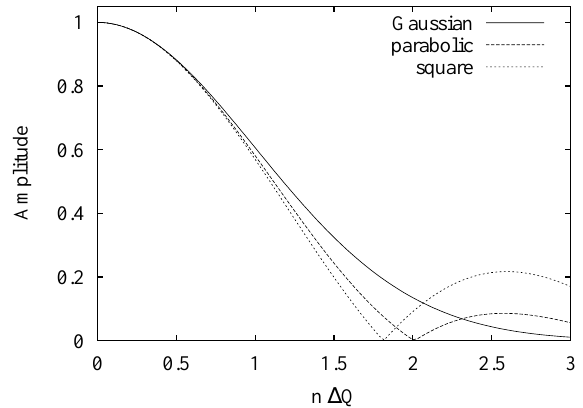
FIG. 8. Evolution of coherent amplitude during decoherence, for three different momentum (tune) distributions. Here, D Q is the rms tune spread and n is the number of